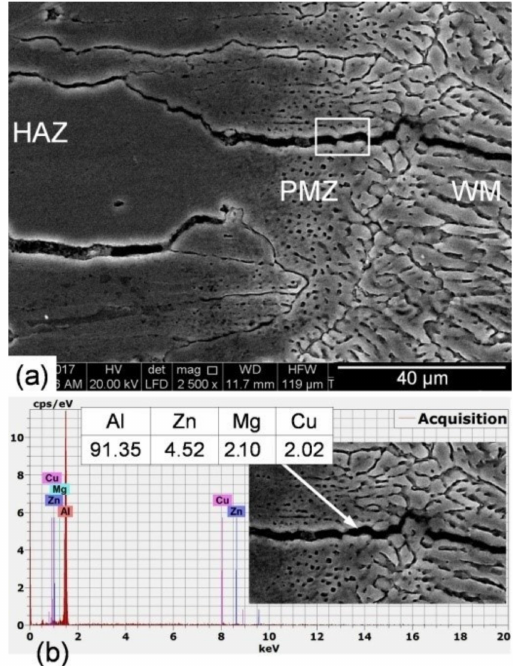
Figure 8. High-magnification SEM photograph of the fusion boundary of the low heat input laser- welded joint ( a ) and typical example of EDS microanalysis of its cracking zone ( b